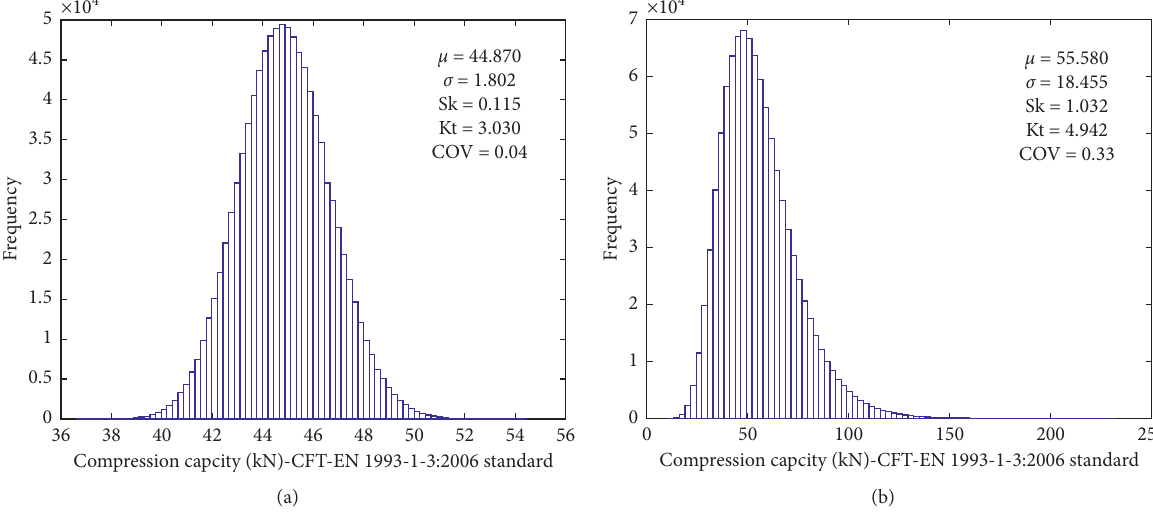
Figure 11: Compression capacity histograms for EN 1993-1-3:2006 Standard: (a) compression capacity without ME; (b) compression capacity with ME. CFT—Column flexure-torsion buckling mode, μ —Mean, σ —Std. deviation, Sk—Skewness, Kt—Kurtosis, and COV—Coefficient of